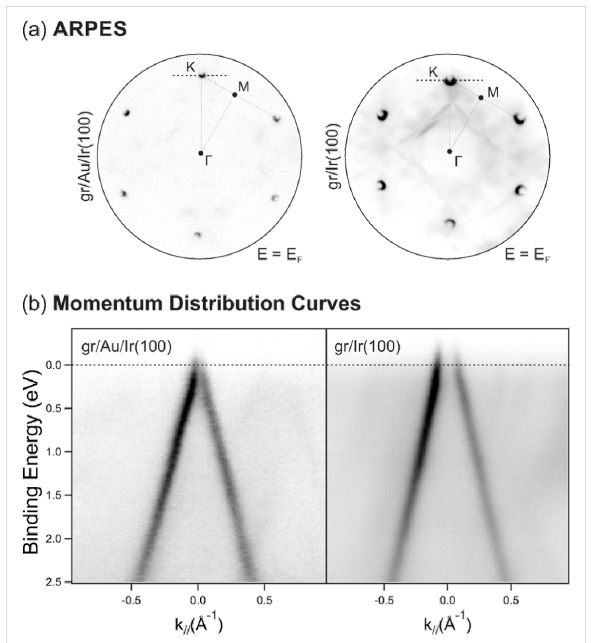
Figure 9: Graphene on Au/Ir(100) (left column) and Ir(100) (right column). (a) μ -ARPES near E F ; the high symmetry points in the first Brillouin zone (FBZ) are indicated. Photon energy is 40 eV. The probed area has a diameter of 2 μ m. (b) Momentum distribution curves along the normal to the Γ –K direction, as indicated by the dashed line in